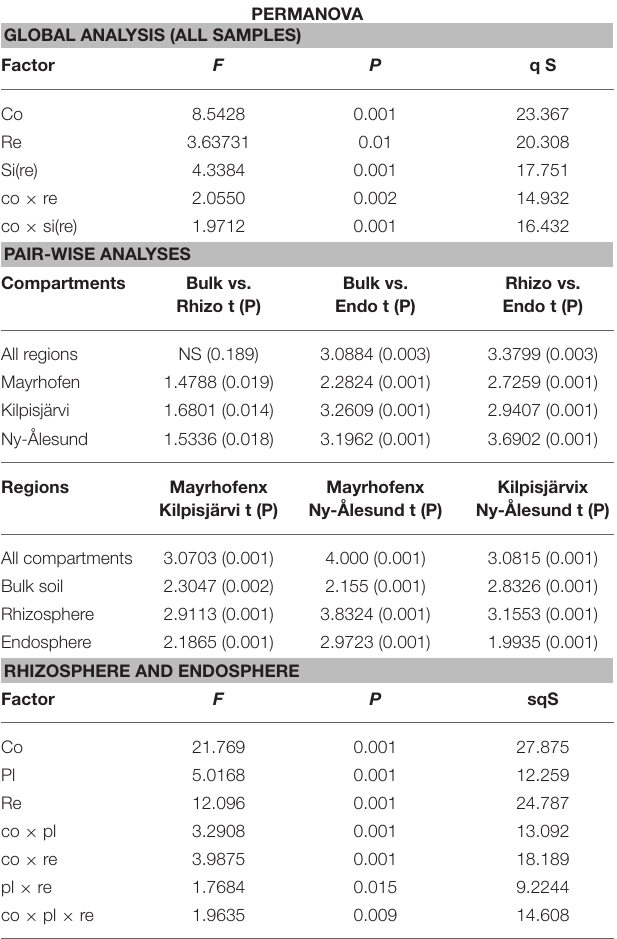
TABLE 1 | Impact of different factors on PNFB community structures. PERMANOVA GLOBAL ANALYSIS (ALL SAMPLES)